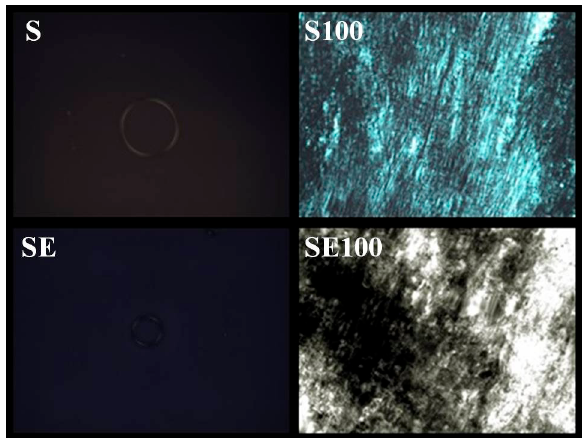
Figure 2. Analyses by PLM of the formulations before and after addition of AVM (20× magnification). Legend: S = Formulation without extract; SE = Formulation with extract; S100 = Formulation + 100% of AVM; SE100 = Formulation with extract + 100% of AVM.